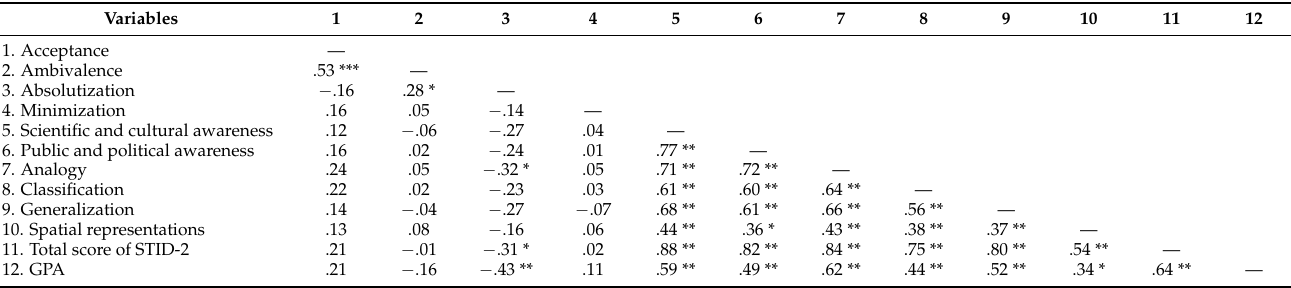
Table 2. Spearman’s correlations between studied variables in general sample of school students ( N =